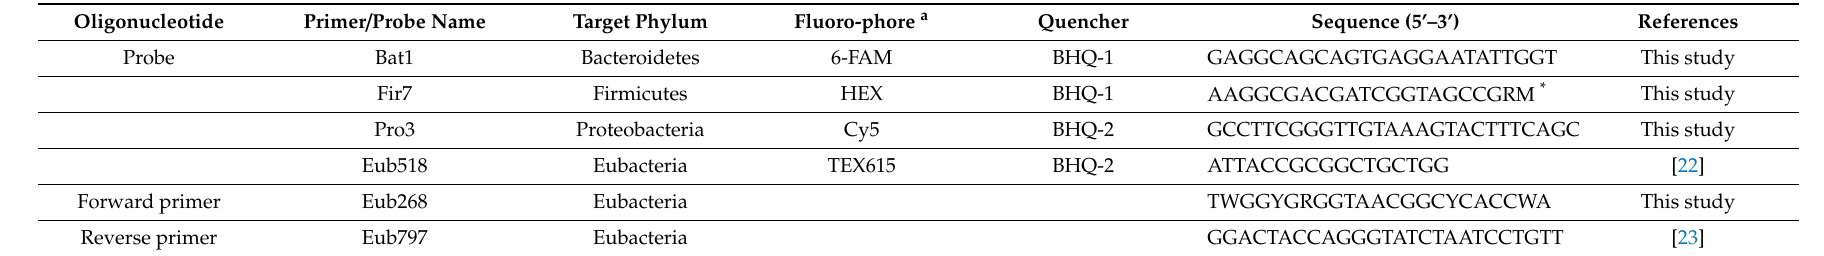
Table 1. Probe and primer design.